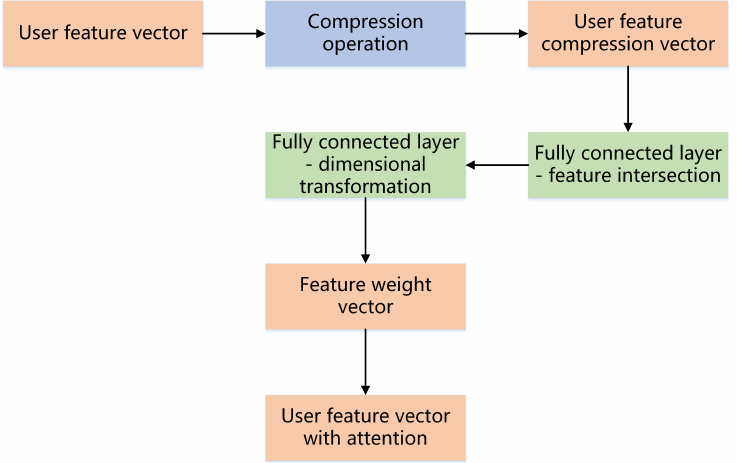
Figure 3. User network feature attention layer processing flow chart. The user feature vector is first obtained as a user feature compression vector then as a feature weight vector and finally as a user feature vector with attention.